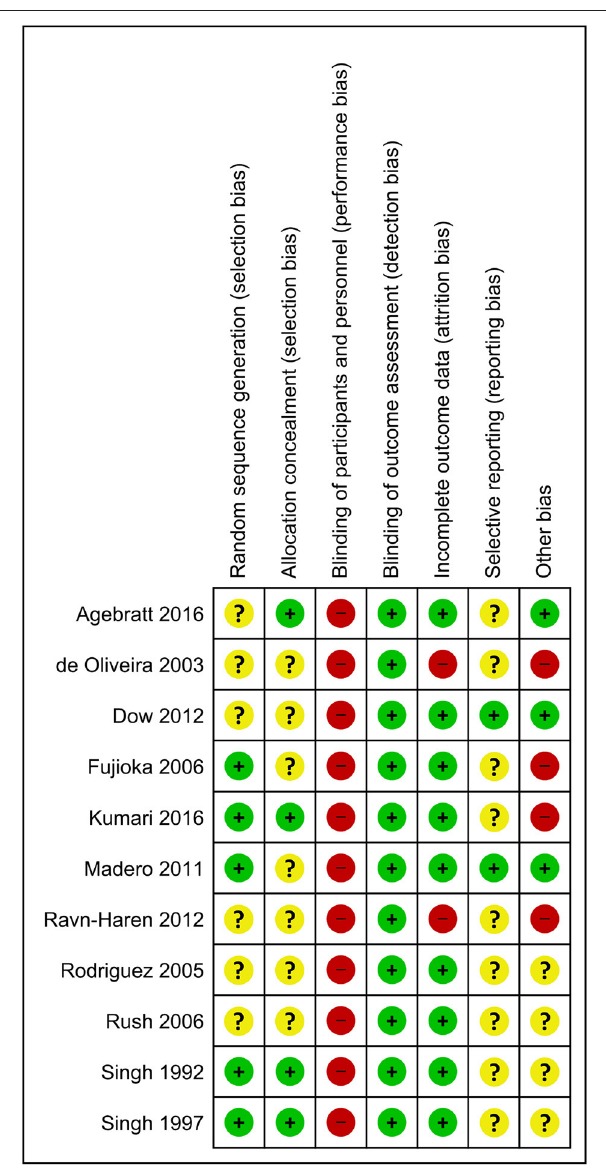
FIGURE 3 | Risk of bias summary for individual trials contributing to the primary outcome: the impact of whole, fresh fruit consumption on measures of body weight and adiposity in RCTs. Colored dots represent low risk (green), unclear risk (yellow), and high risk (red) in each risk of bias domain for each